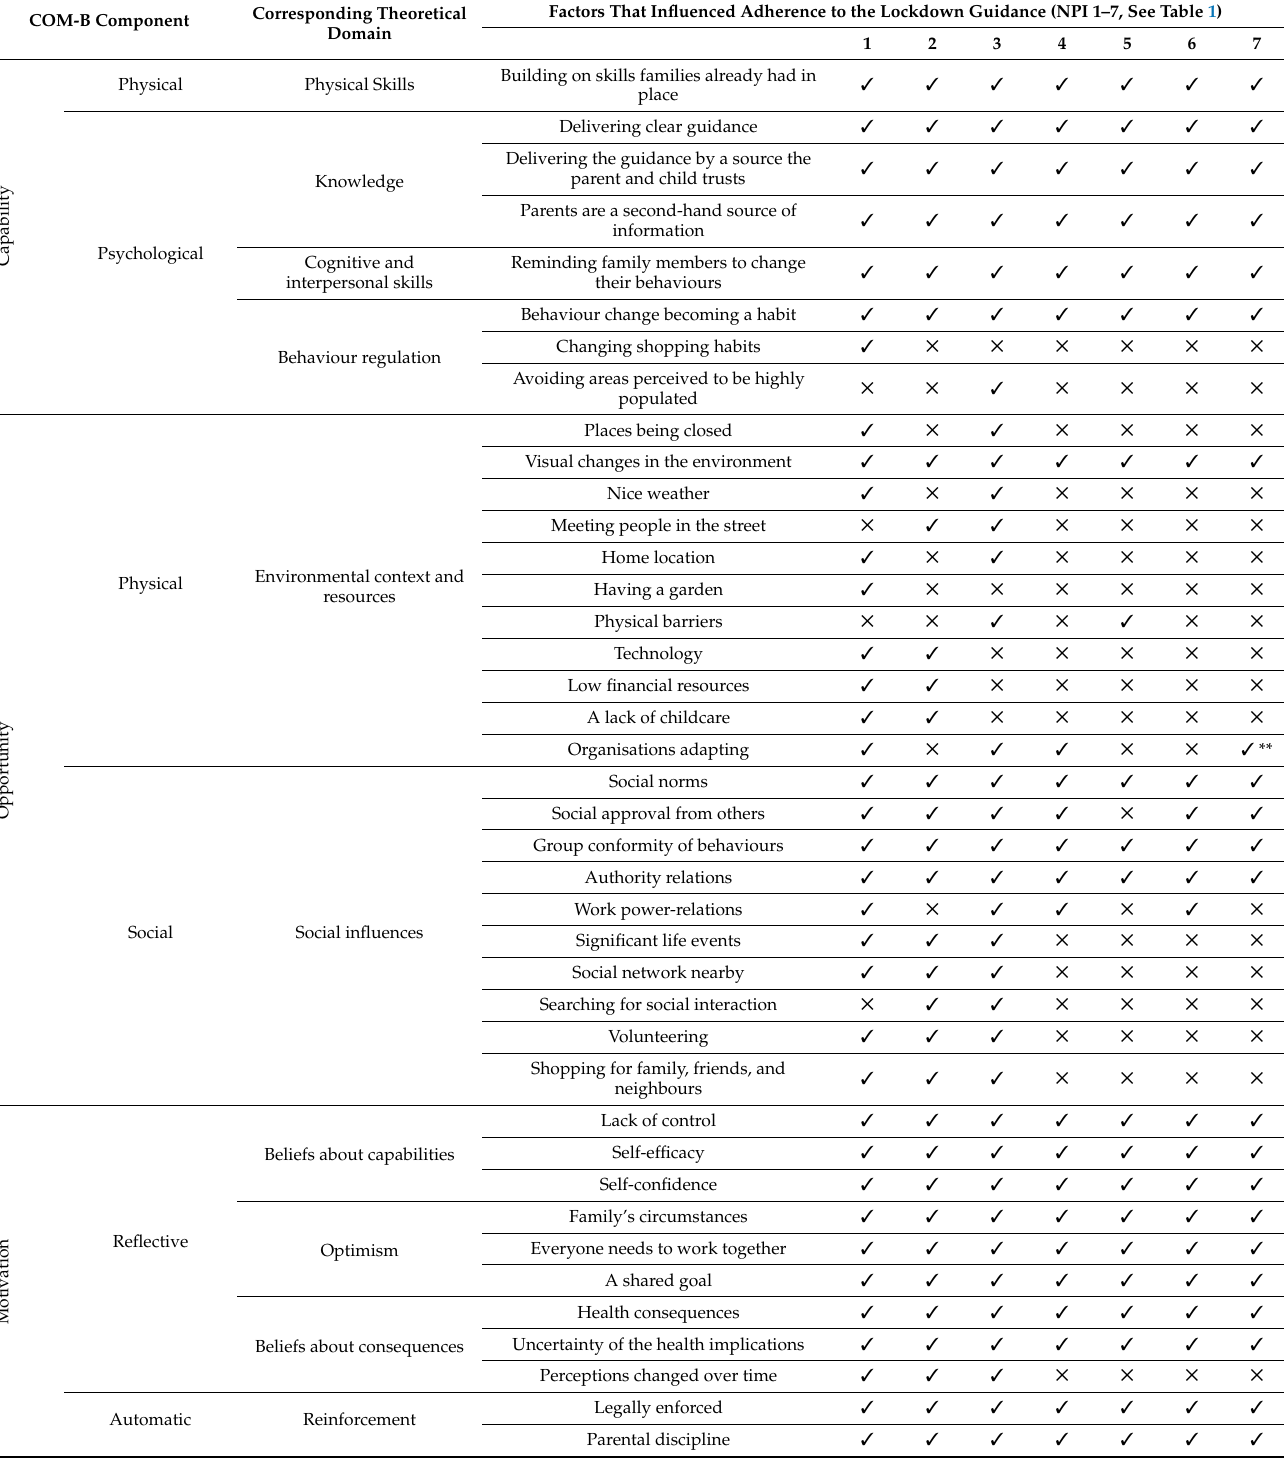
Table 3. Factors (n = 40) that influenced a family’s ability to adhere to seven non-pharmaceutical interventions (NPIs *) implemented in England to control COVID-19 ( (cid:53) Adherence to the NPI was not influenced by the domain, (cid:51) Adherence to the NPI was influenced by the